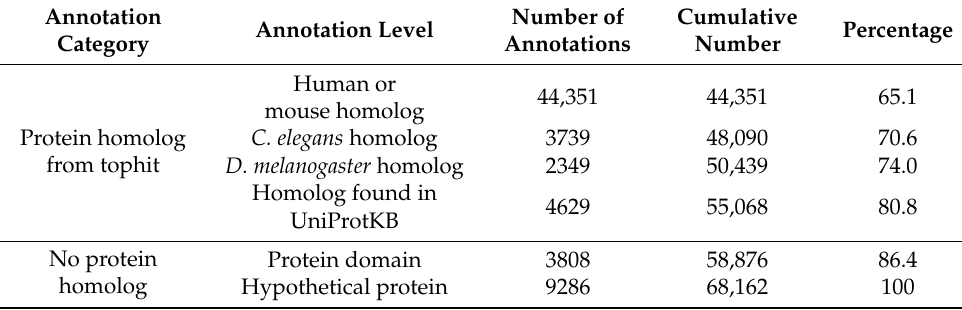
Table 2. Protein-level annotation for E. okinawaensis .